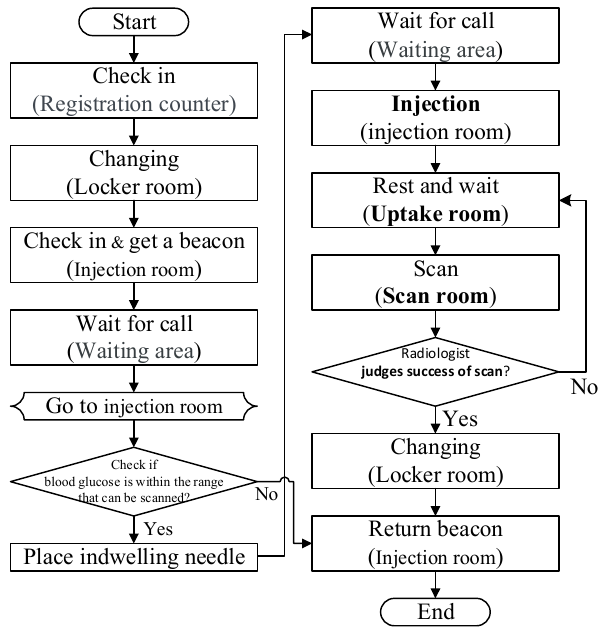
Figure 1. Positron emission tomography (PET) patient examination process.